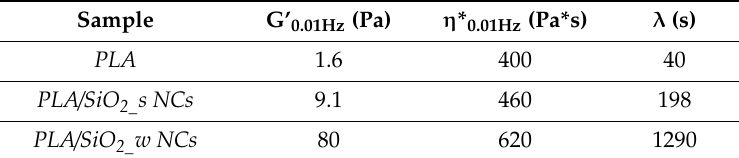
Table 2. Low-frequency (0.01 Hz) rheological parameters.